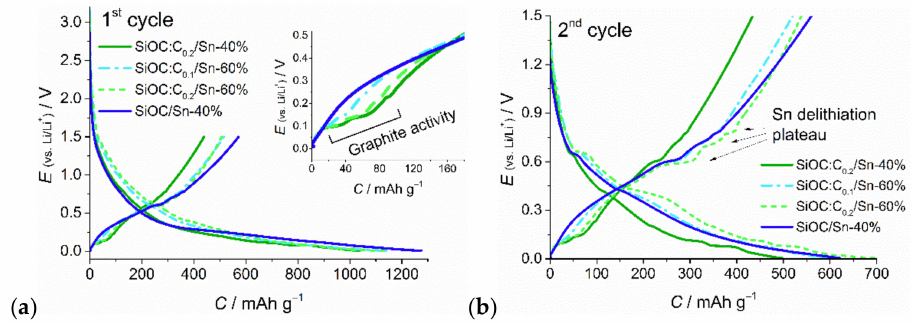
Figure 8. Voltage profiles of the ternary composites: ( a ) 1st cycle, ( b ) 2nd